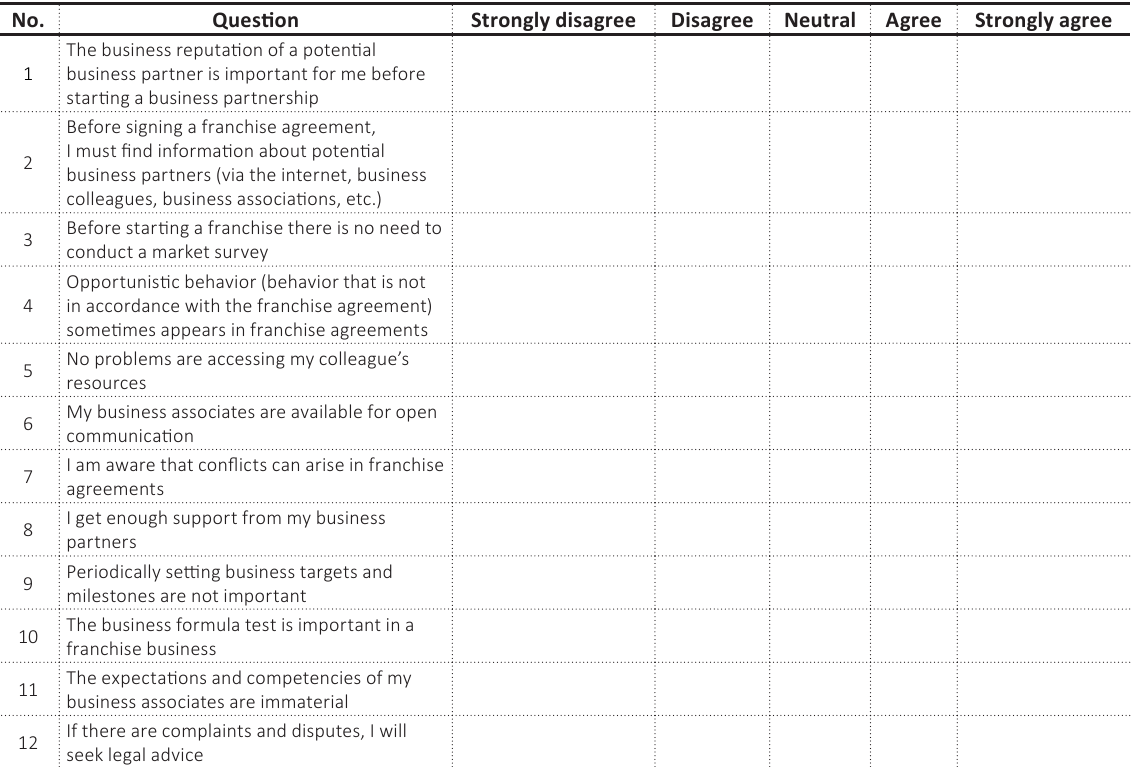
Table B1. Questionnaire and